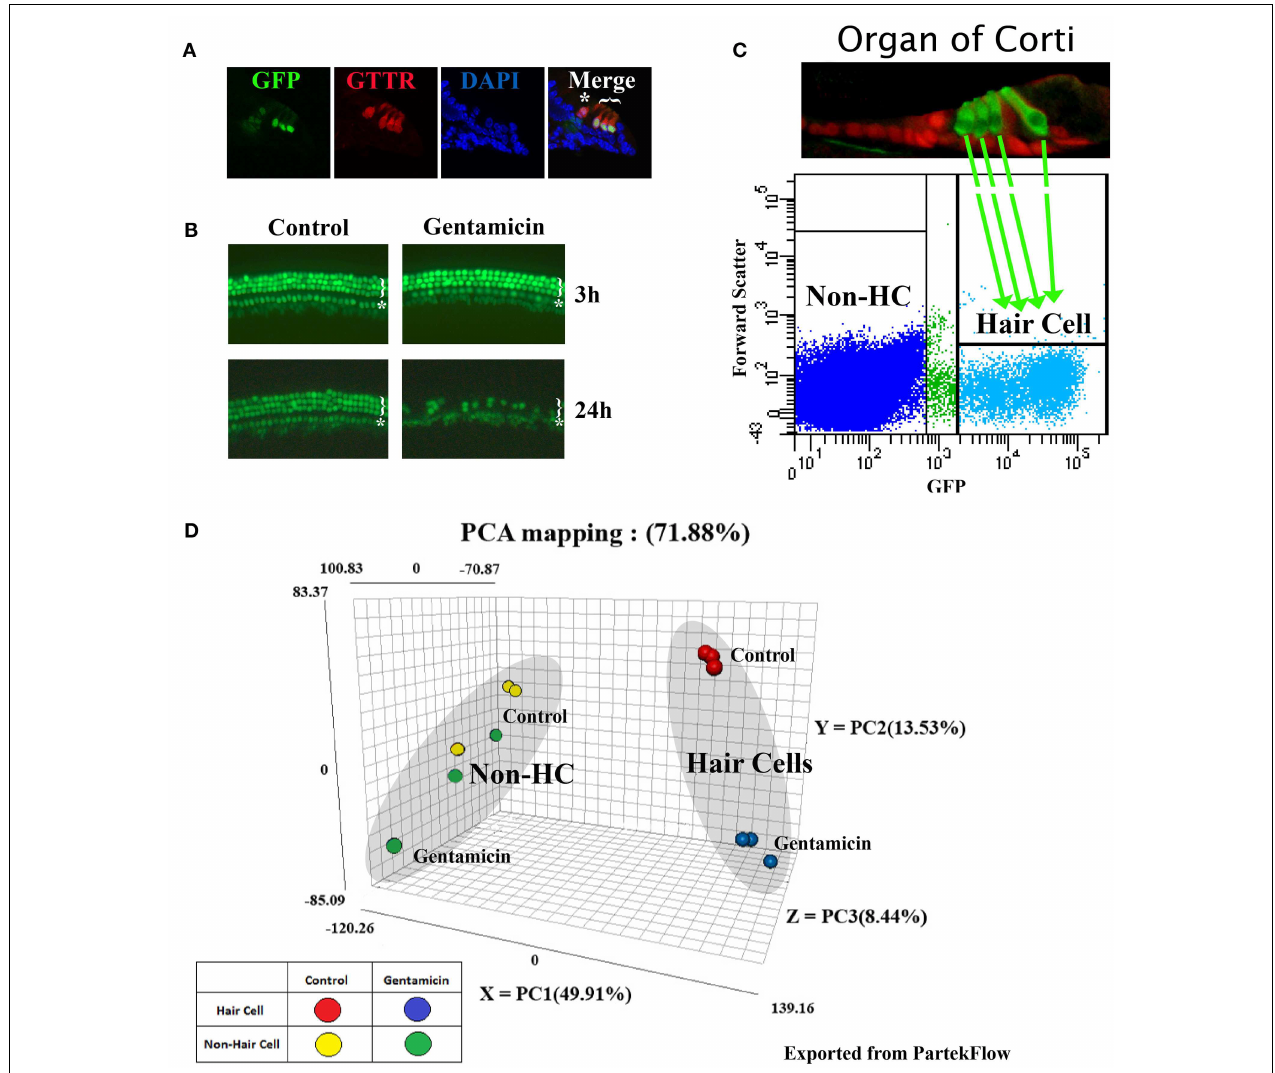
loss at 3h, but severe hair cell damage caused by gentamicin at 24h. Star indicates a single row of inner hair cells and bracket indicates three partial rows of outer hair cells. (C) Scatter plot of Atoh1-GFP hair cell purification by FACS shows gate settings and diagram shows a P1 organ of Corti indicating hair cells (green) and supporting cells (red) (Chen and Segil, 1999). (D) PCA map showing the three most significant variances among samples. 78.88% of variance in the combined dataset is captured in the analysis; (49.91% in PC1-X axis, 13.53% in PC2-Y axis, and 8.44% on PC3-Z axis). Each dot represents one biological